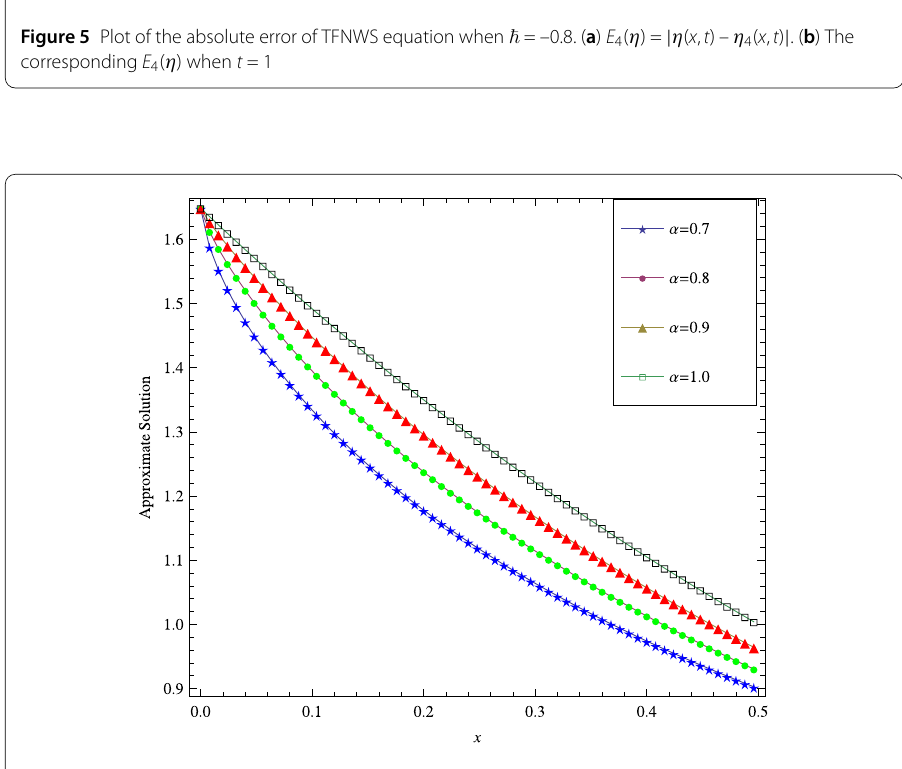
Figure 6 Plot of η 4 ( x , t ) vs. time t at x = 1 and different values of β